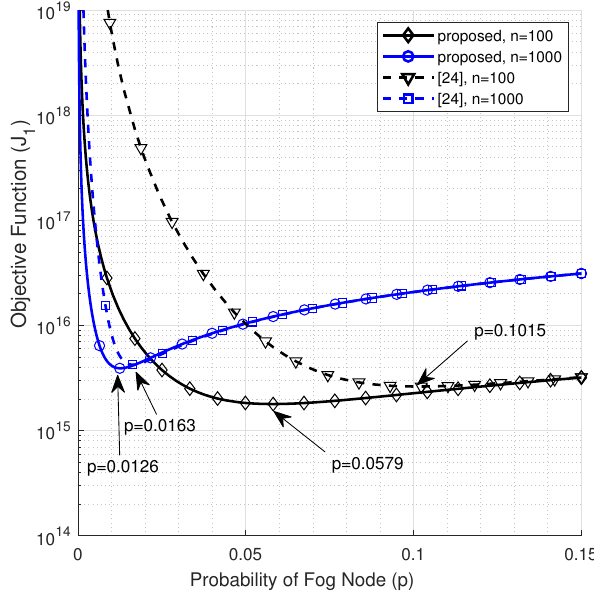
Figure 2. The objective function vs. p utilizing SS-PLM at α x = α y =